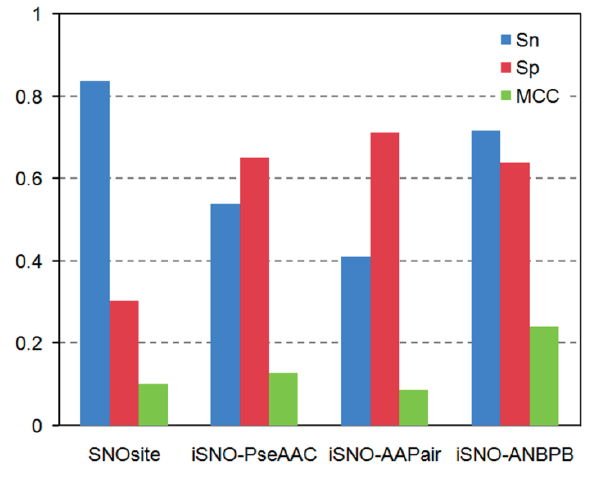
Figure 1. Potential S -nitrosylation sites predicted on 37 proteins through S -nitrosothiols (SNO)site, iSNO-PseAAC, iSNO-AAPair and iSNO-adapted normal distribution bi-profile Bayes (ANBPB)